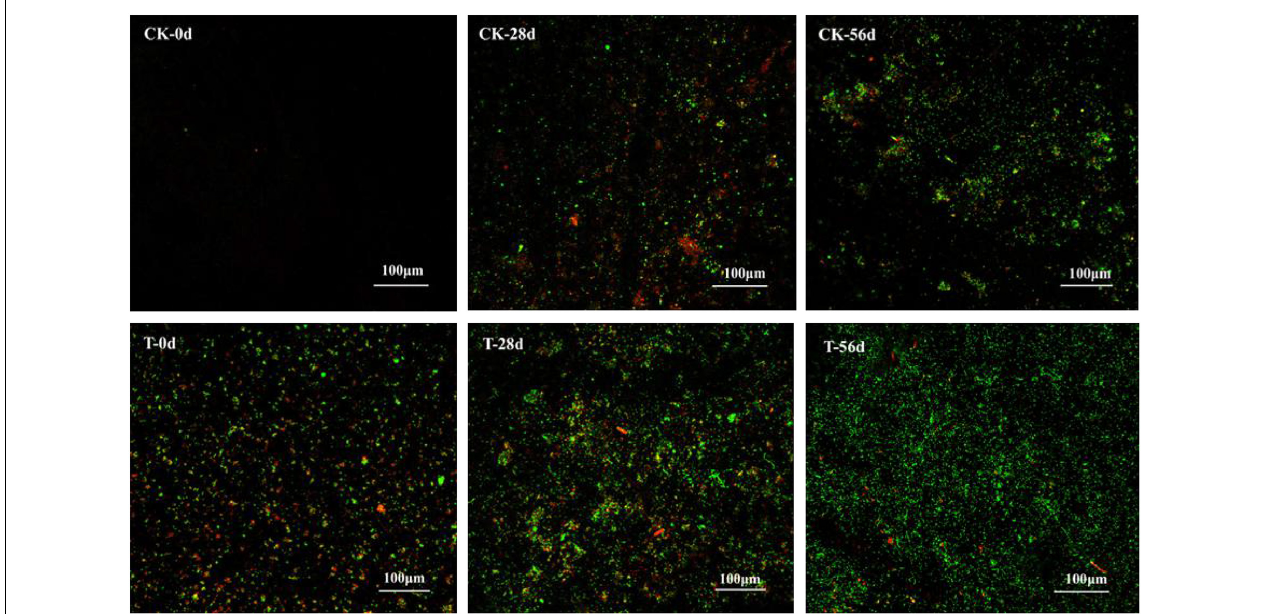
FIGURE 5 | Biofilm on the PHPS observed under CLSM. The fluorescence of which includes PI (red) for dead cells, and SYTO9 (green) for living cells. The bars represent 100 µ m.